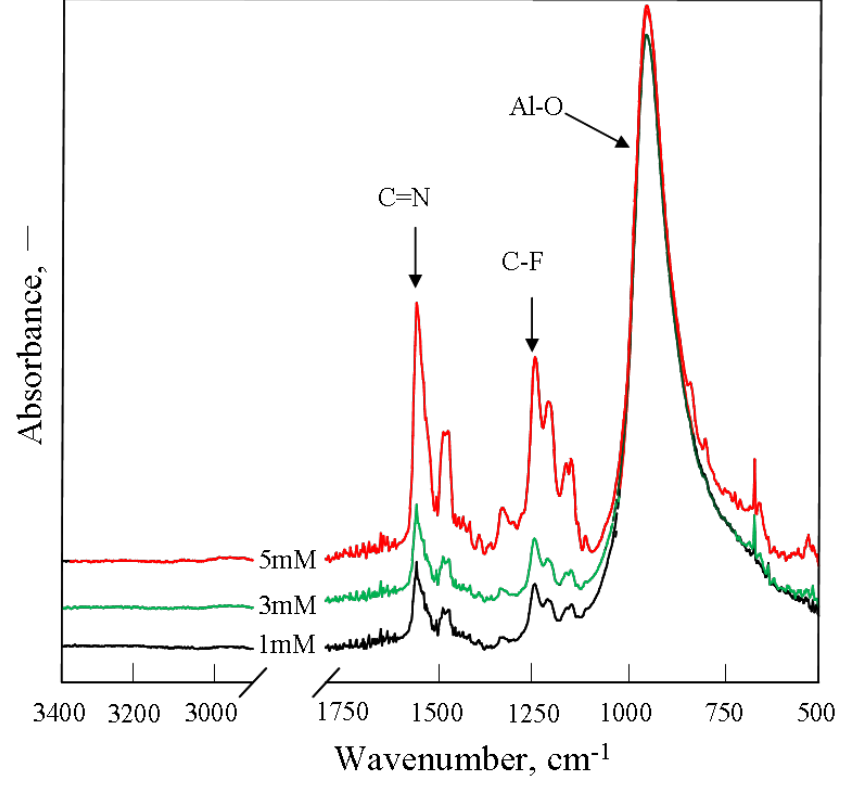
Figure 2. FT-IR spectra of PAF17 nanofilm obtained under different AF17N